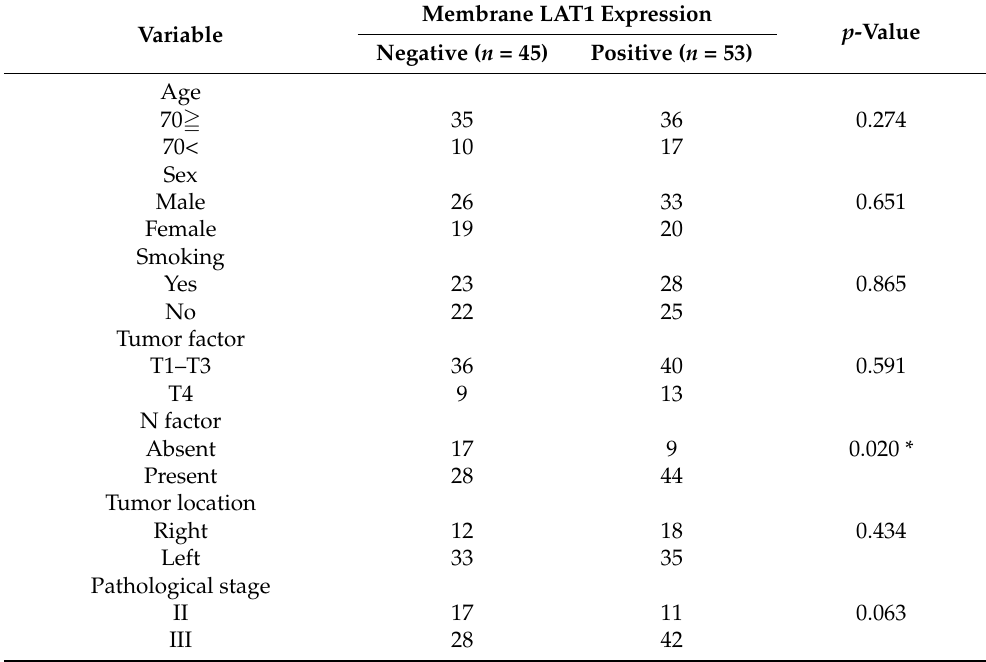
Table 1. Relationship between LAT1 positivity and various clinicopathological factors.